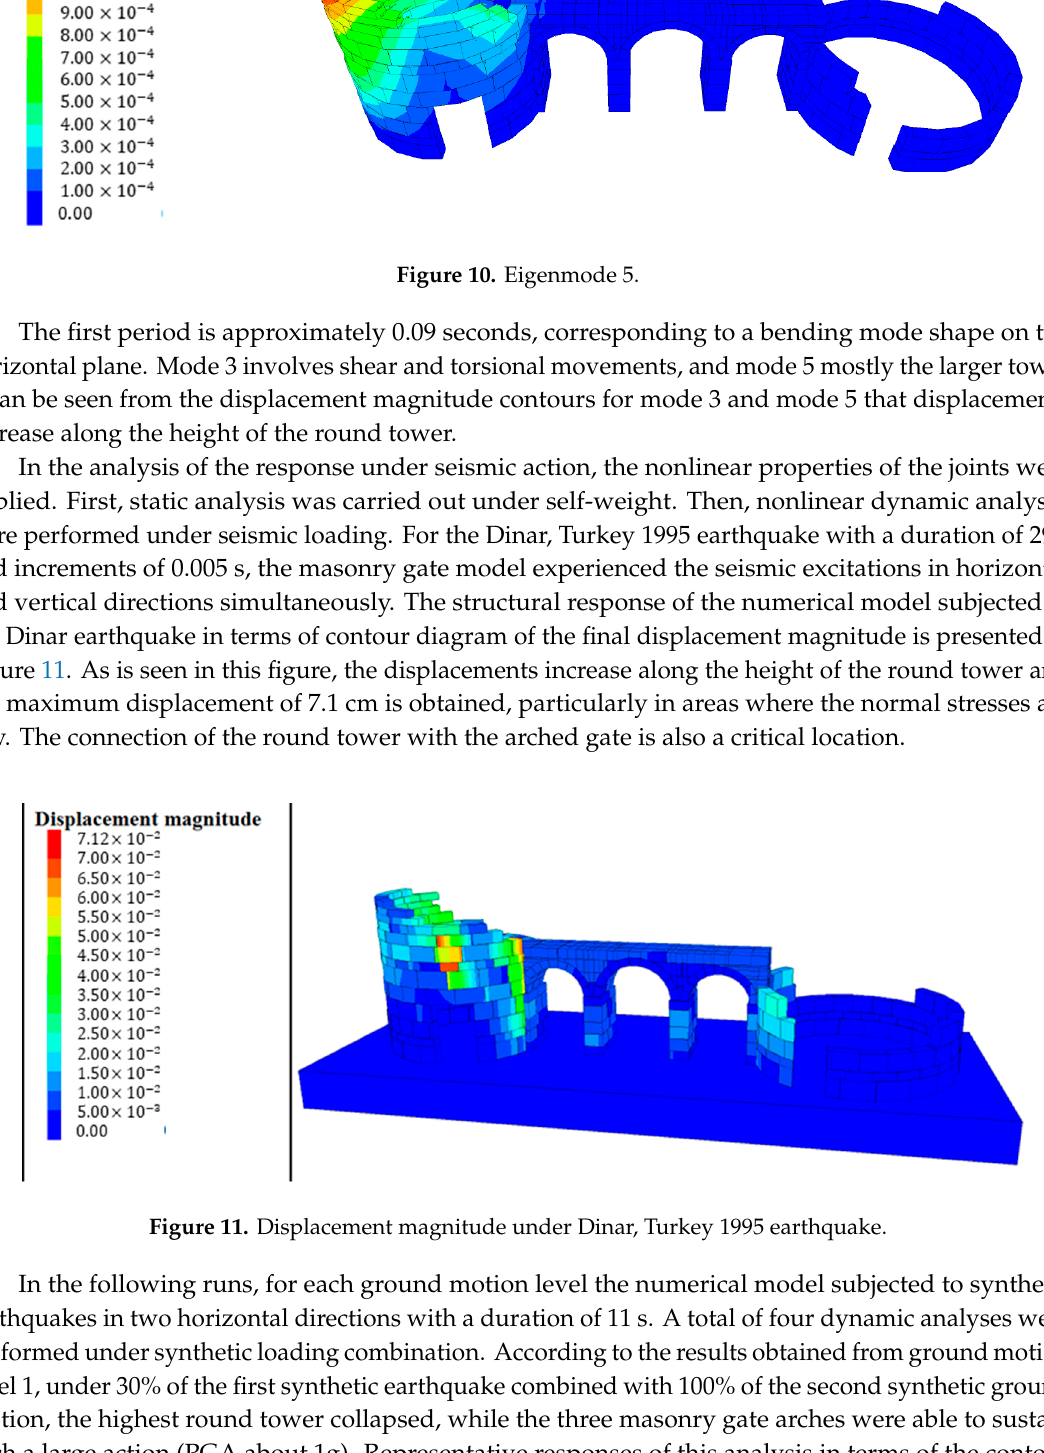
Figure 12. Displacement magnitude for ground motion level 1, under 30% of the first synthetic earthquake combined with 100% of the second synthetic ground motion . Figure 13. Displacement magnitude for ground motion level 2, under the first case as 100% of the first synthetic earthquake combined with 30% of the second synthetic ground motion .